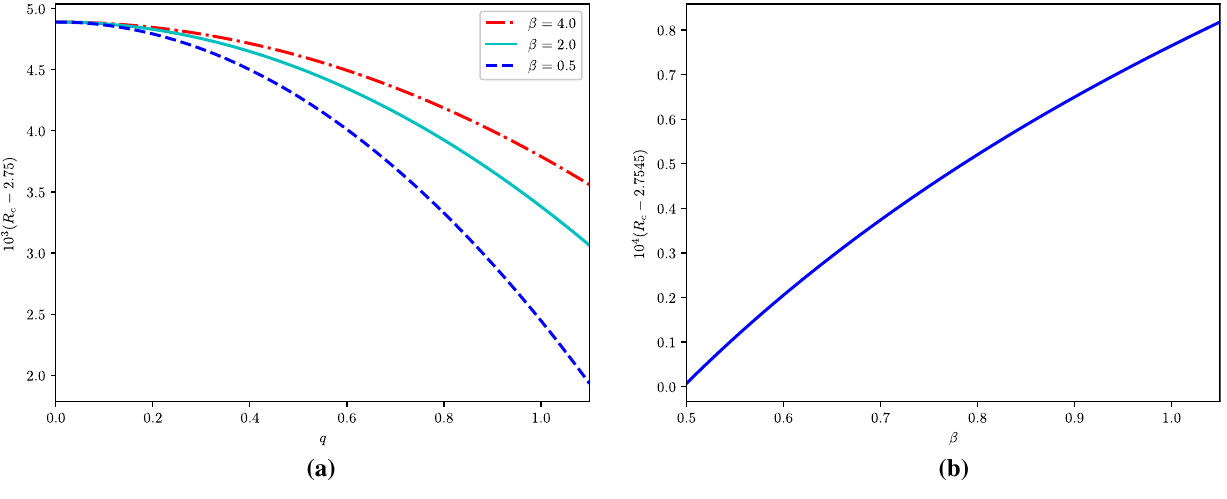
Fig. 4 Gaussian source: the dependence of the radius of screening with a precision of 0.9 on a the charge q and b the strength of self-interaction √ β (for q = 0 . 4). In both cases, R = 1 / 10 / s